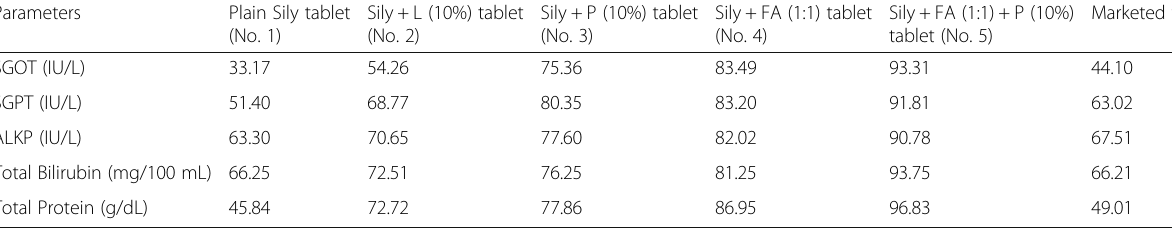
Table 2 Percent recovery of serum parameters